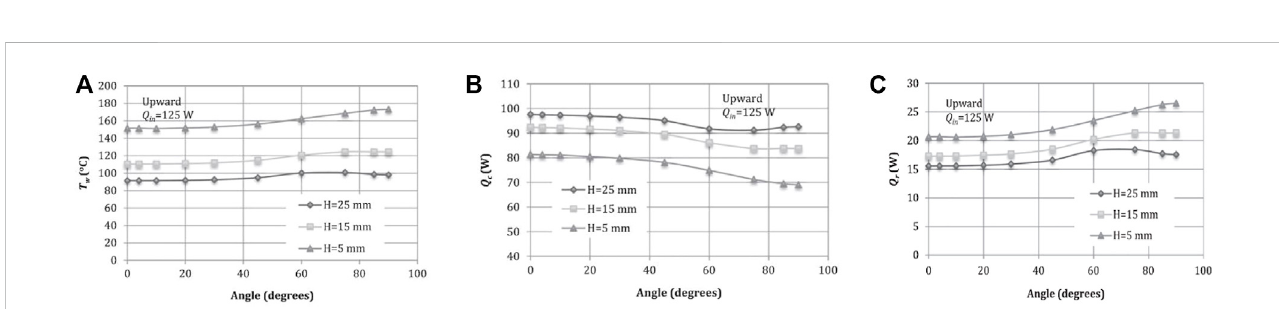
FIGURE 12 Relationbetween (A) .Averagesurfacetemperature; (B) .ConvectiveHeatTransferRate; (C) .RadiativeHeatTransferRateandinclinationangleforH=15, 20 25 mm and Q in = 125 W for upward inclinations (Tari and Mehrtash,